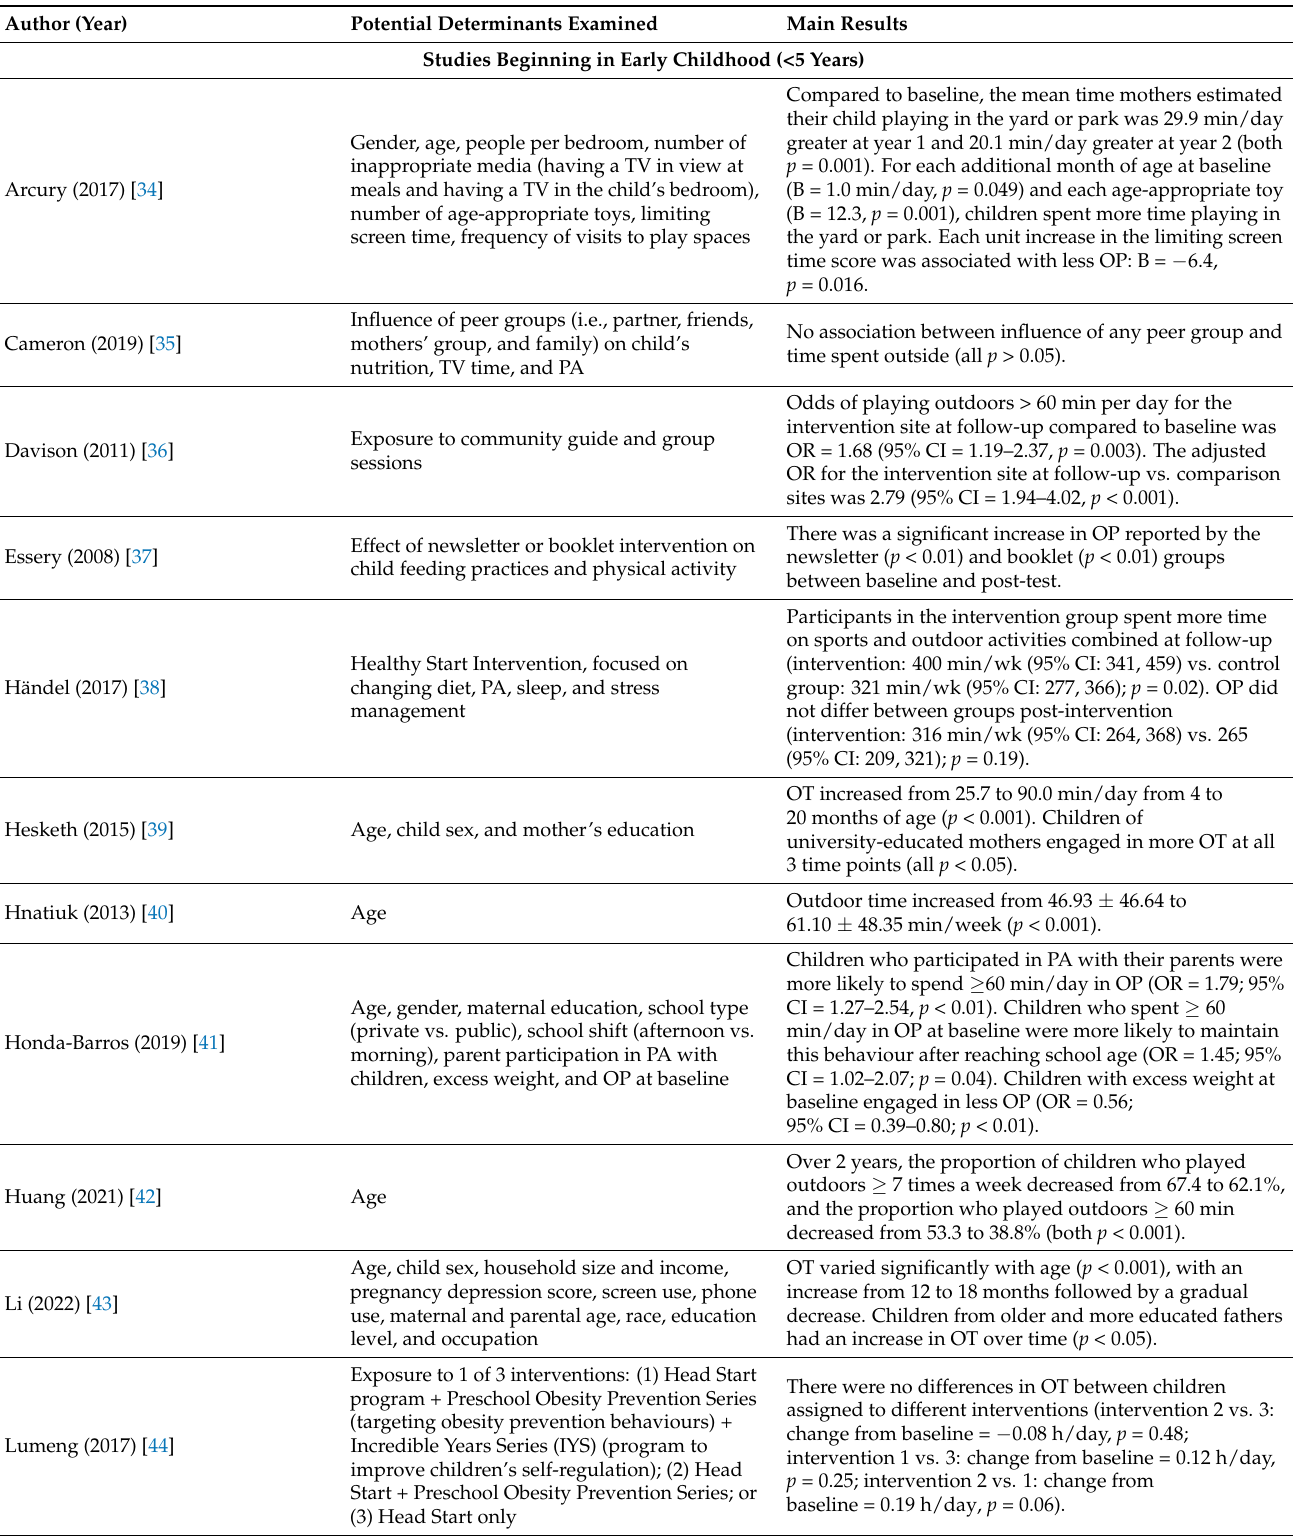
Table 2. Determinants of outdoor time in children and